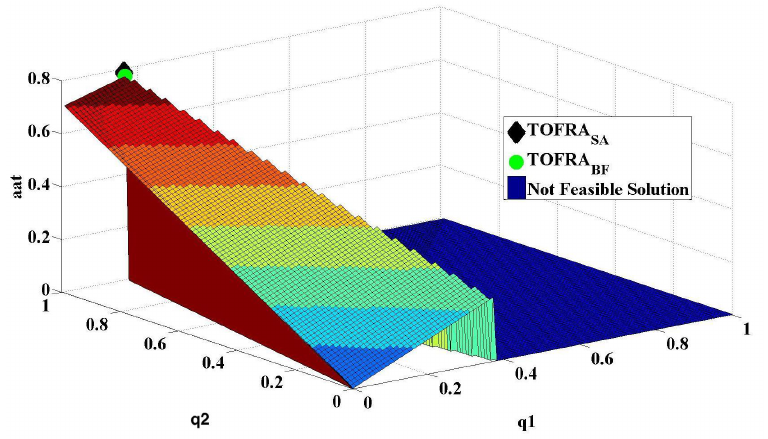
Figure 14. Simulated annealing vs. brute force, test case 6: Topology = 1, γ = 2.0, Interference handling: